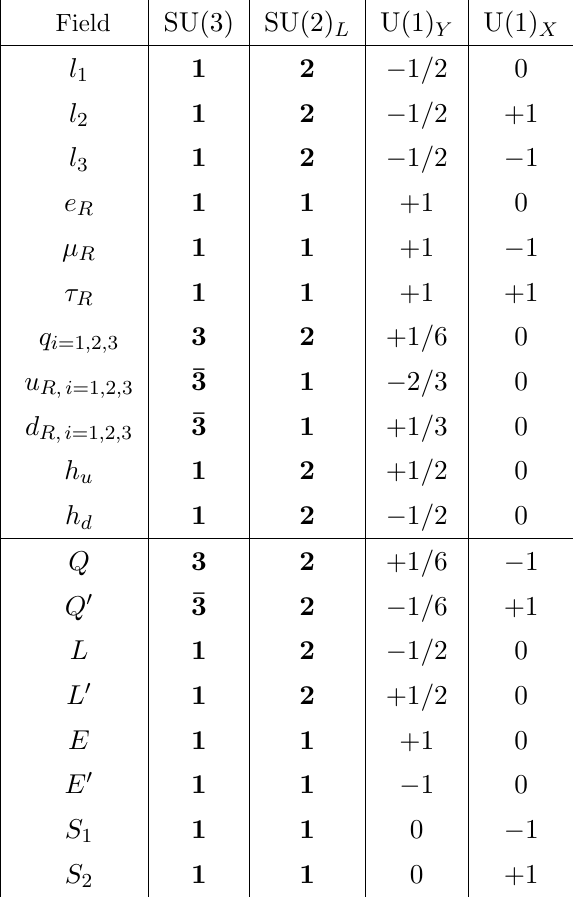
Table 4. The left-chiral super(cid:12)elds of the model and their gauge quantum